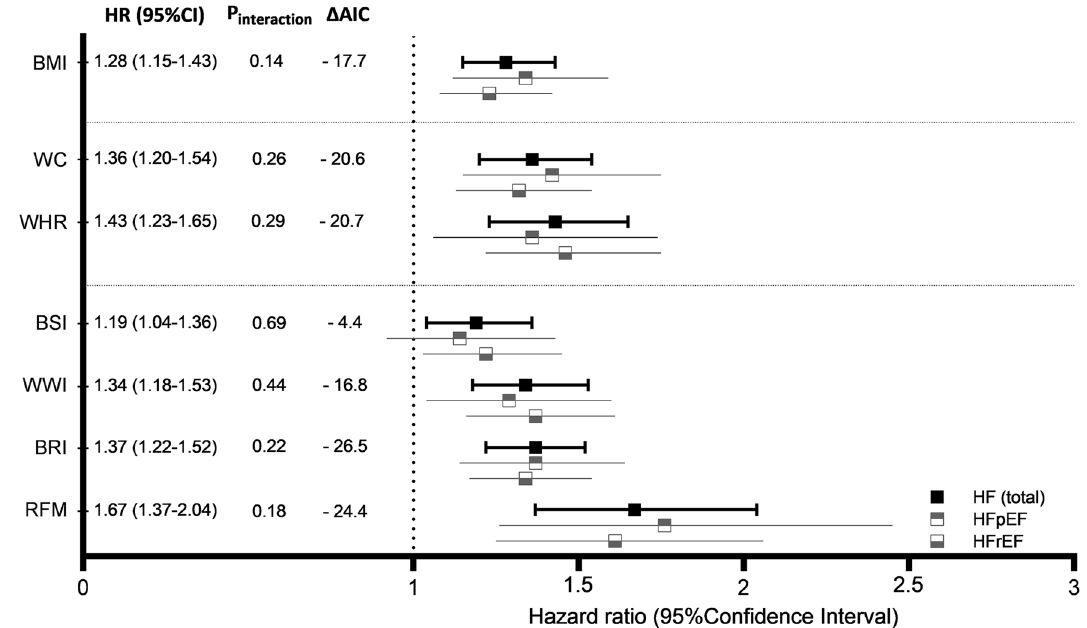
Figure 2. Associations of adiposity indices with incident heart failure. Models were adjusted for age, sex, smoking, cholesterol, systolic blood pressure, glucose, and history of myocardial infarction, stroke and atrial fibrillation. HR represents the hazard ratio per standard deviation change in adiposity index; CI represents confidence interval; P interaction represents the P-value for sex × covariate interaction. AIC Akaike information criterion, BMI body-mass index, BRI body roundness index, BSI body shape index, HF heart failure, HFrEF HF with reduced ejection fraction, HFpEF HF with preserved ejection fraction, RFM relative fat mass, WC waist circumference, WHR waist-to-hip ratio, WWI weight-adjusted-waist index. Young (< 55 years) Middle-aged (55–65 years) Old (≥ 65 years) n = 5847 n = 1459 n =